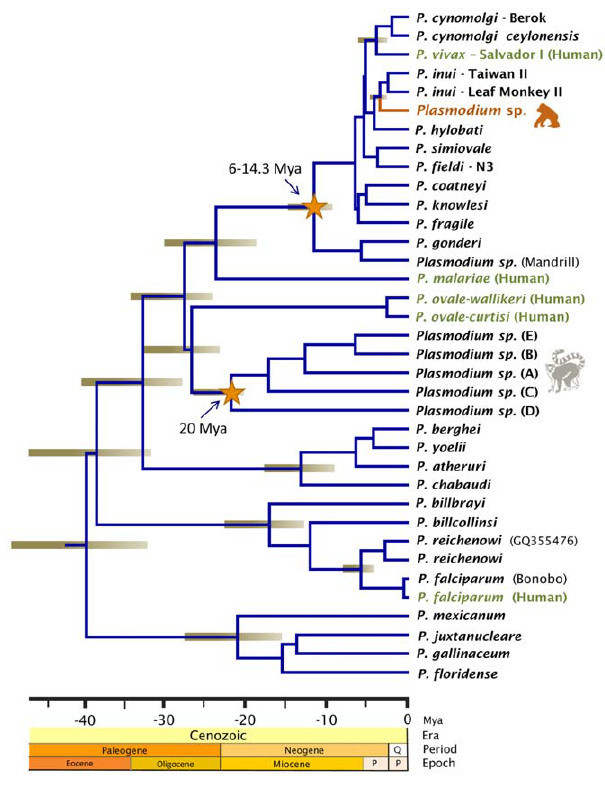
Figure 5. Timetree of the divergence of orangutan malarial parasites. Divergence times were estimated with BEAST using two calibrations points: the host divergence Papio/Macaca (6–14.3 Mya) and a minimum of 20 Mya for the origin of lemur parasites. Time is shown in millions of years ago (Mya).